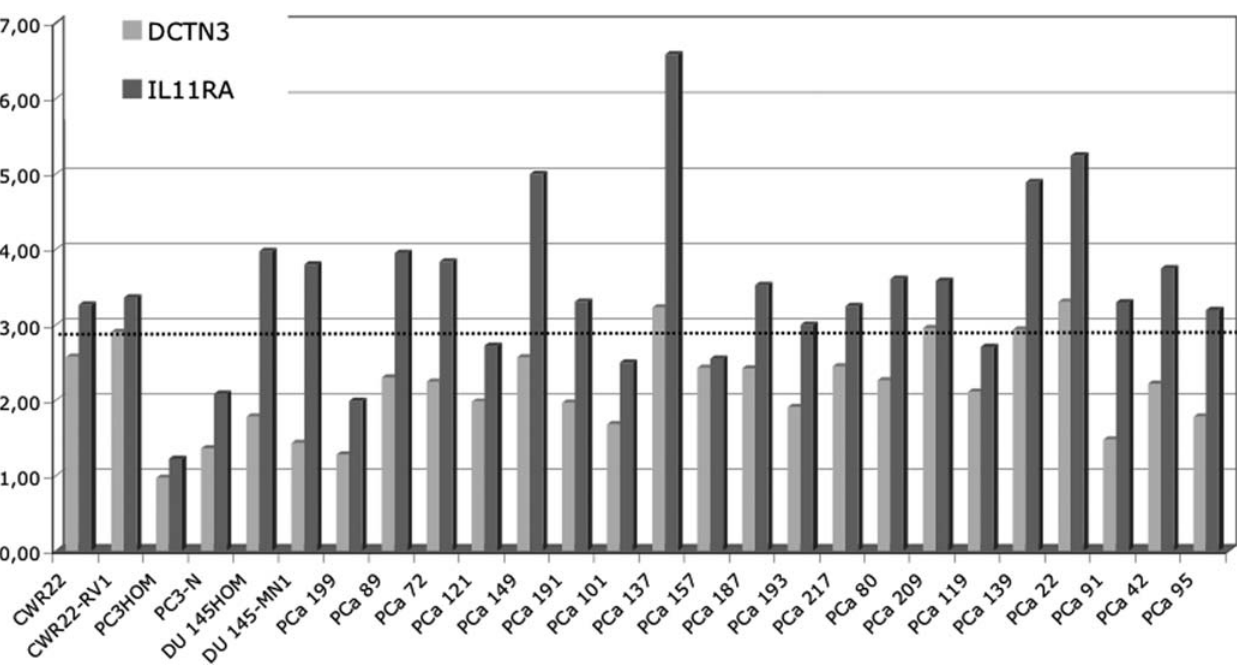
Figure 4. DNA copy number quantification ofDCTN3andIL11-RAgenes in prostate cancer cell lines and 20 primary prostate carcinoma samples using quantitative real time PCR. IL-11RA showed a significant increase in gene copy number above normal in CWR22, CWR22-Rv1, DU145 HOM and DU145-MN1 and in 15 out of the 20 (75%) prostate cancer samples. For DCTN3 , no copy number gain was detected in any cell line and in only 2 out of the 20 (10%) prostate cancer samples. Values above cut off line being assigned as increased gene copy number compared to